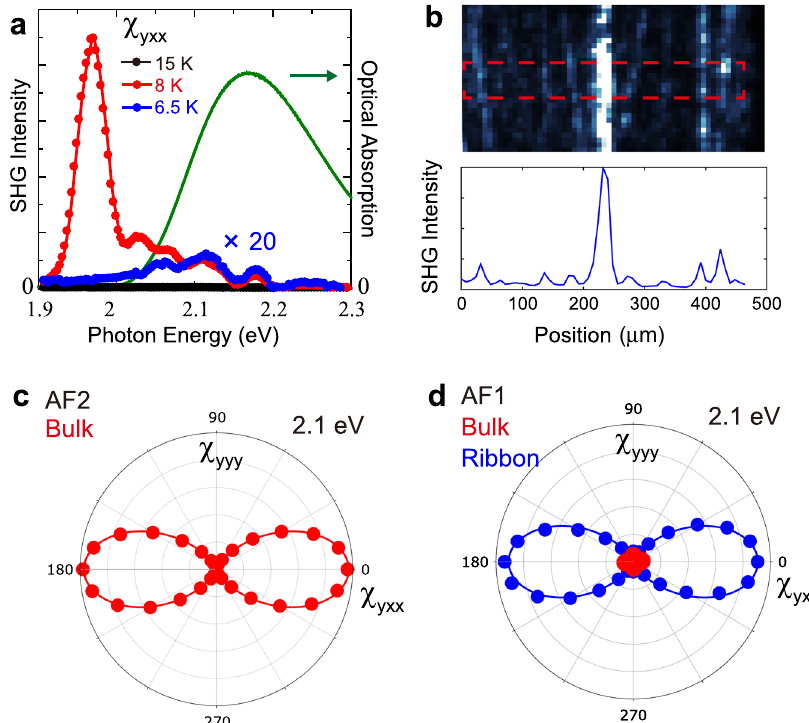
Fig. 2 SHG spectrum, line pro fi le, and polarization dependence. a SHG spectrum measured for the tensor component χ yxx . The green line shows the optical absorption spectrum measured at 15 K. b Line pro fi le (red outline) of the SHG intensity at 6.5 K in the AF1 phase. c and d SHG polarization anisotropy with the polarization of E 2 ω jj y measured with varying polarization of fundamental light in the c multiferroic AF2 phase and d non-multiferroic AF1 phase. The SHG intensity from the AF1 dark bulk region (red) is one order of magnitude weaker than that in the AF1 multiferroic ribbons (blue). Solid lines are fi ts of the tensor component χ yxx